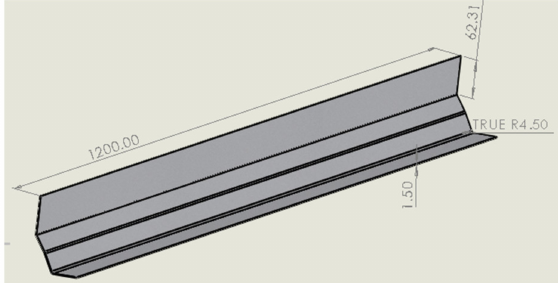
Figure A8. Bottom cover (Dimensions in mm).